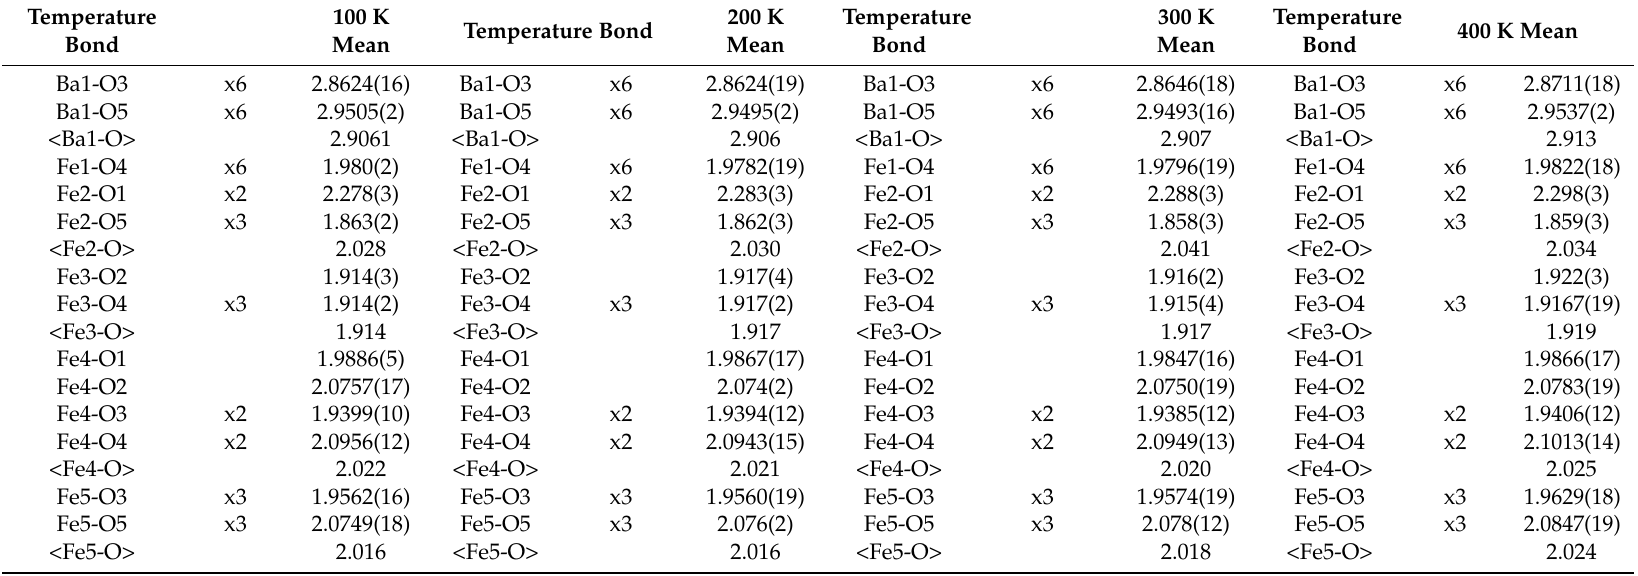
Table 4. Selected bond distances (Å) for the crystal structures of barioferrite at 100, 200, 300, and 400